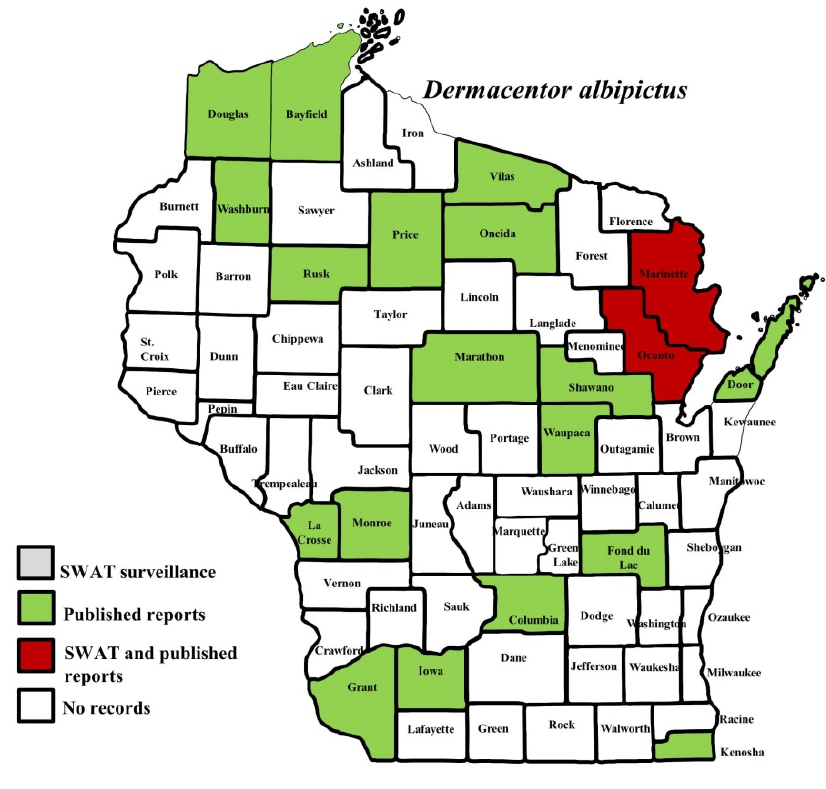
Figure 9. County records for Dermacentor albipictus in Wisconsin [1,6,20,27,29].